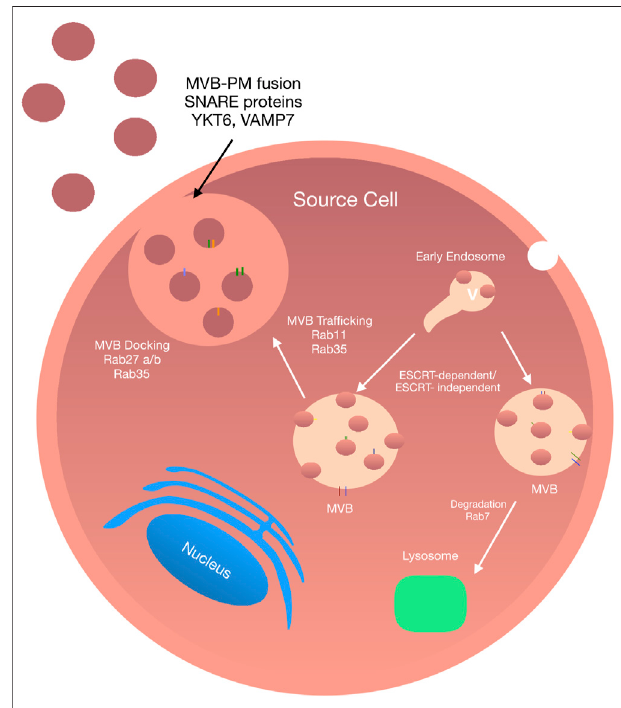
FIGURE 1 | Exosome Biogenesis: Exosomes biogenesis is a complex process and can be conducted in an ESCRT-dependent and -independent manner. The internalisation of the plasma membrane initiates the formation of exosomes by endocytosis. The fusion of early endosomes results in the production of multivesicular bodies. Upon maturation, MVBs are directed to the plasmamembrane via atightly Rab GTPase dependent multistep process where they undergo a SNARE-mediated plasma membrane fusion event followed by secretion into the extracellular